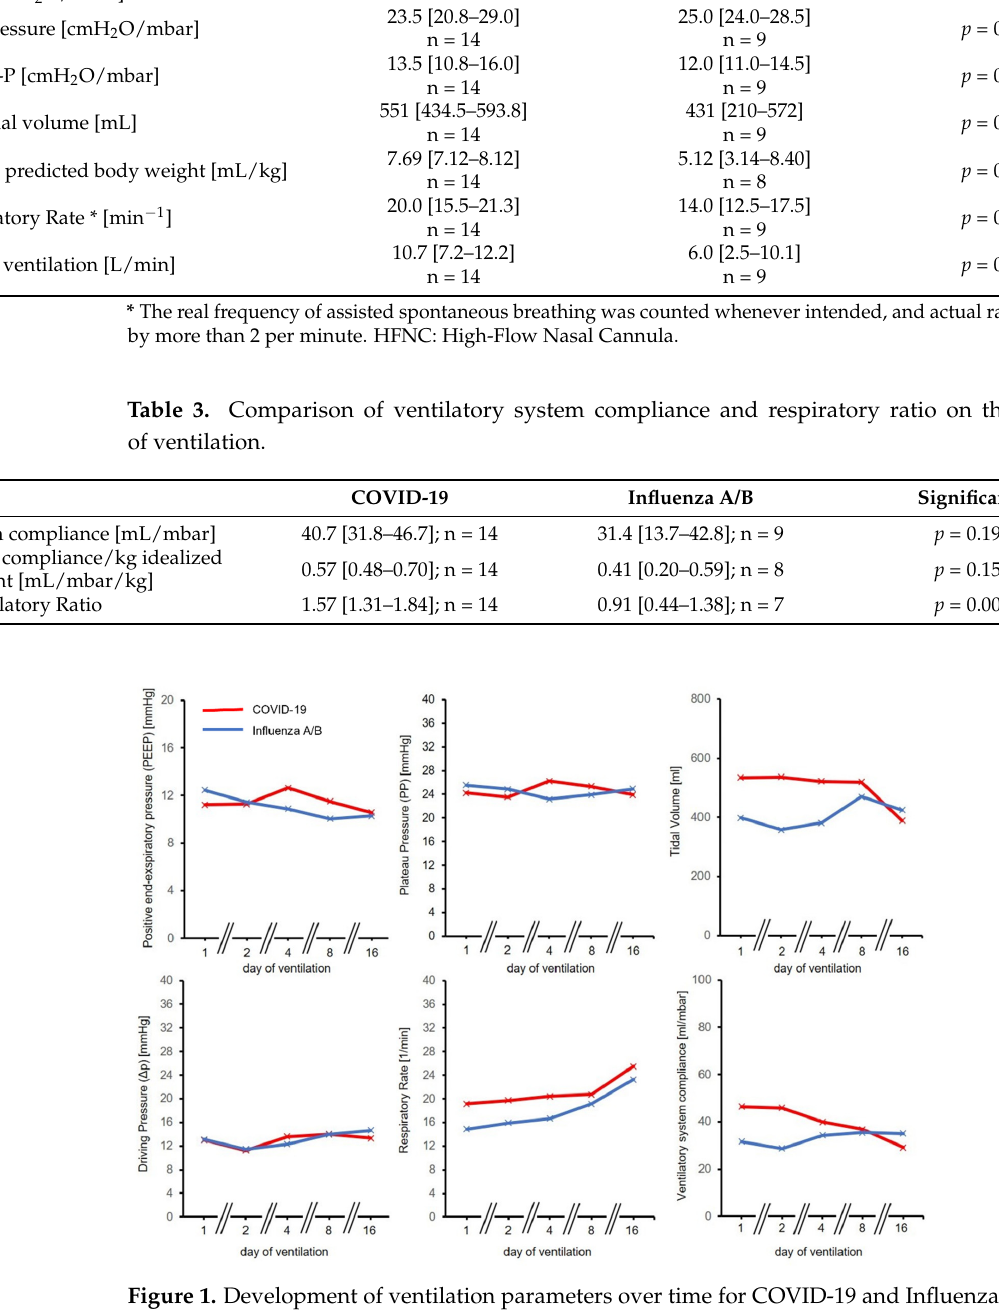
Figure 1. Development of ventilation parameters over time for COVID ‐ 19 and Influenza A/B. Time course was similar in both groups for positive end ‐ expiratory pressure (PEEP), Plateau Pressure (PP) and Driving Pressure ( Δ P). Respiratory Rate (RR), Tidal volumes and ventilatory system com ‐ pliance were initially higher for the COVID ‐ 19 group.